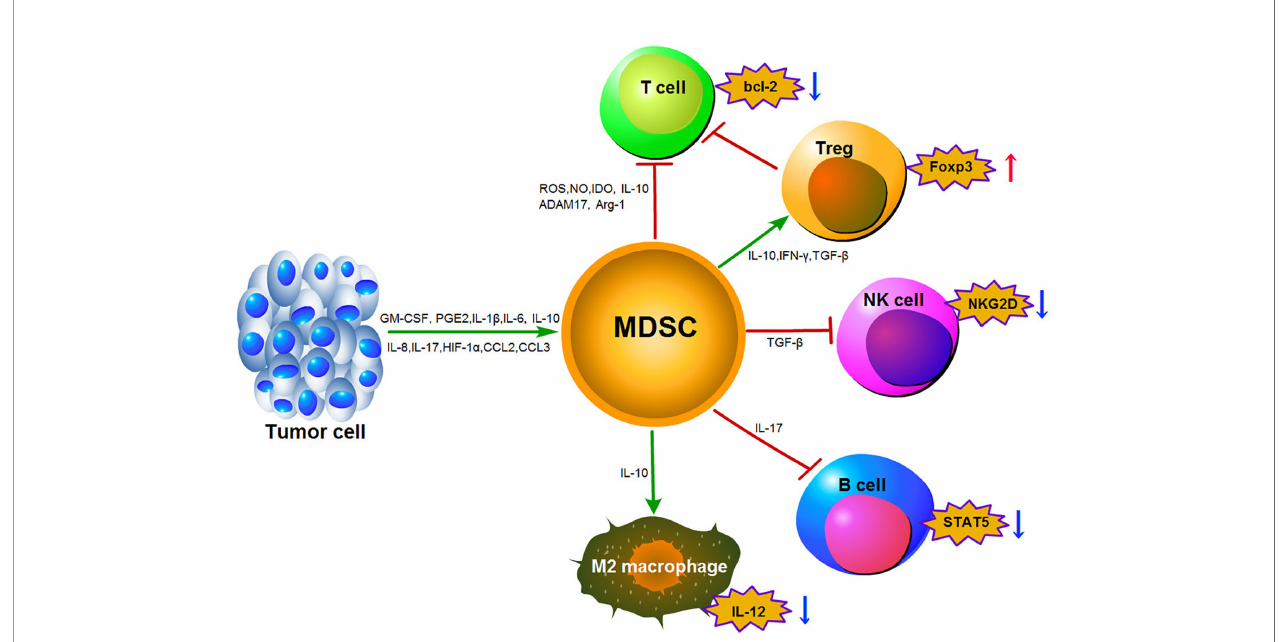
FIGURE 1 | Main mechanisms of immunosuppression function mediated by MDSCs in the tumor